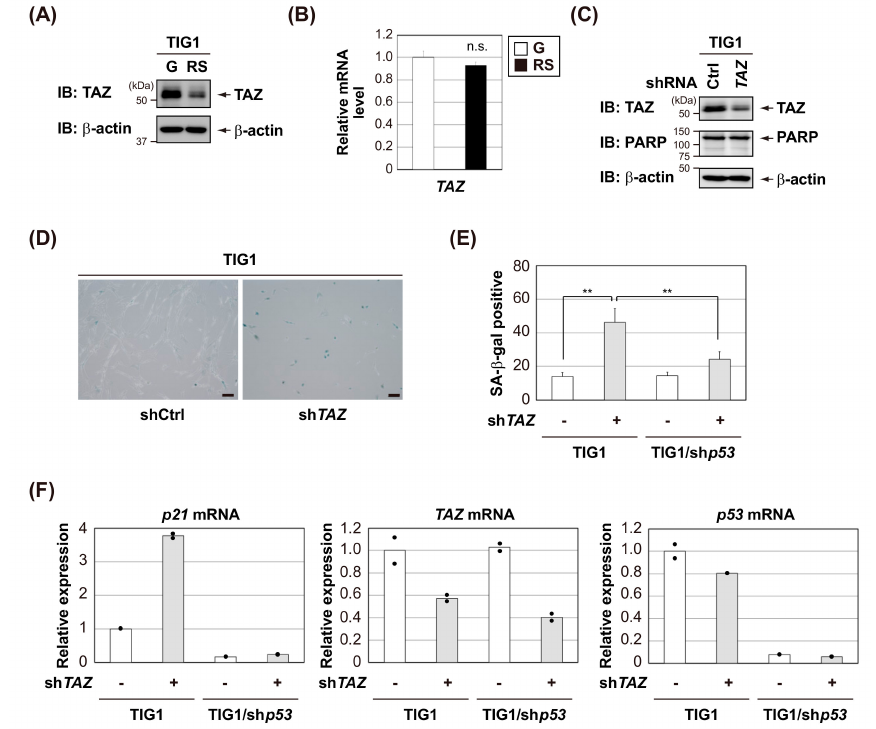
Figure 5. TAZ knockdown induces p53-dependent senescence in normal human fibroblasts. ( A ) TAZ was down-regulated in replicative senescent TIG1 cells. Total protein was extracted from TIG1 cells with PD30 (G: growing) or PD65 (RS: replicative senescence), and immunoblotting analysis was performed with the indicated antibodies. ( B ) Total RNA was extracted from TIG1 cells with PD30 (G) or PD65 (RS), and the expression of TAZ mRNA was assessed by qPCR. mRNA level of TAZ was normalized with β -actin mRNA. Result is shown as means ± S.D ( n = 3). ( C – F ) TIG1 cells were infected with lentiviral vectors containing shRNA for TAZ (sh TAZ ) or control (shCtrl) for 7 d. Total cell lysates were harvested for an immunoblot analysis with the indicated antibodies ( C ). Cells were then stained for senescence-associated β -gal (SA- β -gal). Representative images of the indicated cells stained for SA- β -gal activity (scale bar, 100 µ m) ( D ). The bar graph shows the percentage of SA- β -gal–positive cells in the indicated culture ( E ). The expression of each gene was assessed by qPCR (duplicate determination), and the mRNA levels of the indicated genes were normalized with β -actin mRNA ( F ). Significant di ff erences are indicated as ** p < 0.01. n.s.: not